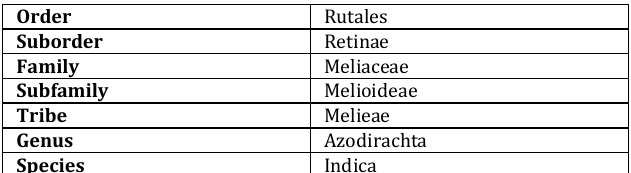
Table 2: Taxonomic position of Azadirachtaindica (neem) [6].